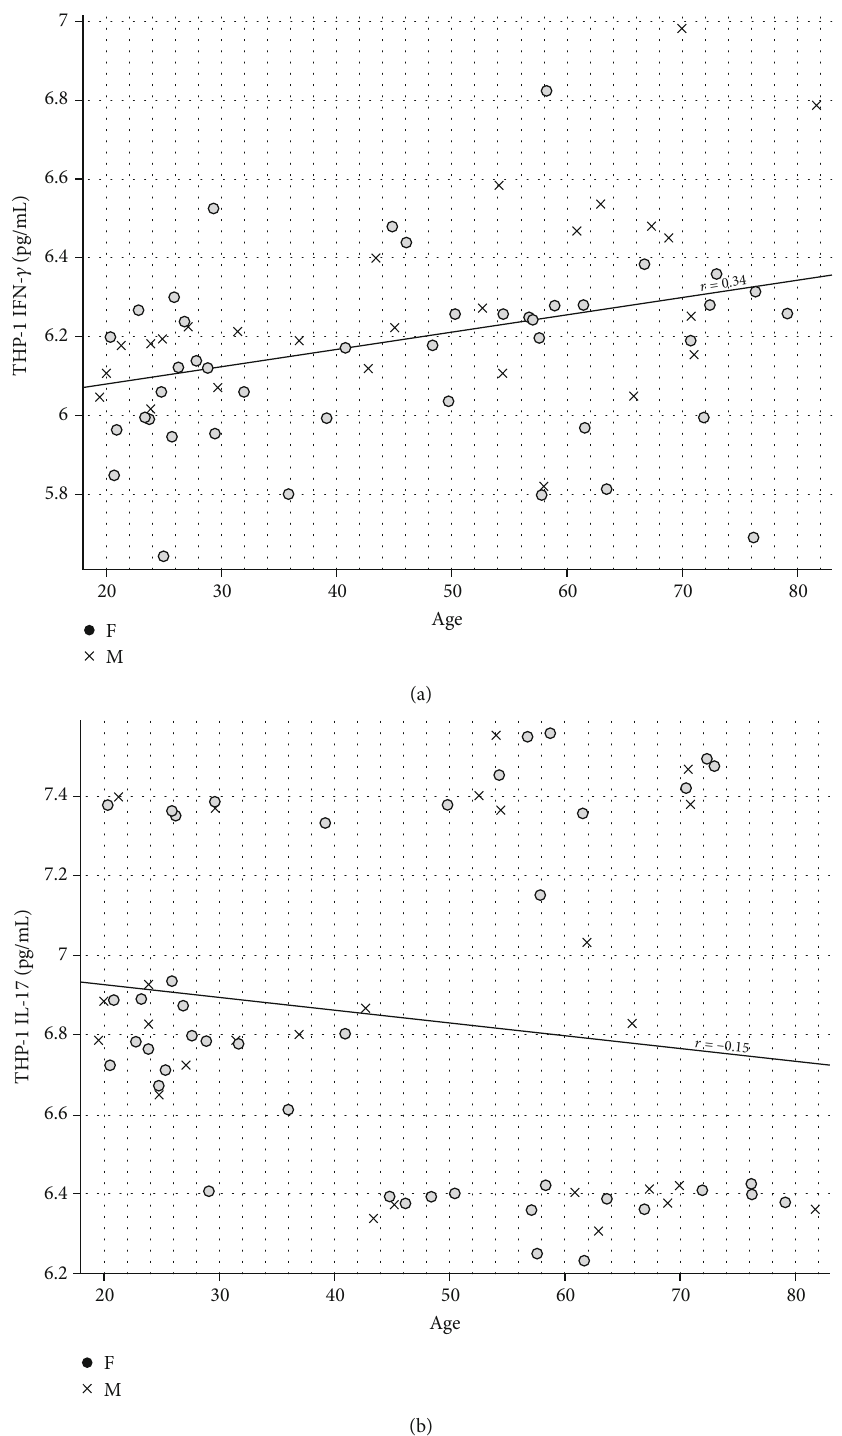
Figure 8: Correlation of age ( X axis), cytokine production by THP-1 cells (macrophages) quanti fi ed in the supernatant by ELISA after 24h of stimulation with CCD or CTRL EVs ( Y axis) and sex ( • : female; X: male). (a) IFN- γ ( r = 0 : 34 ). (b) IL-17 ( r = − 0 : 15